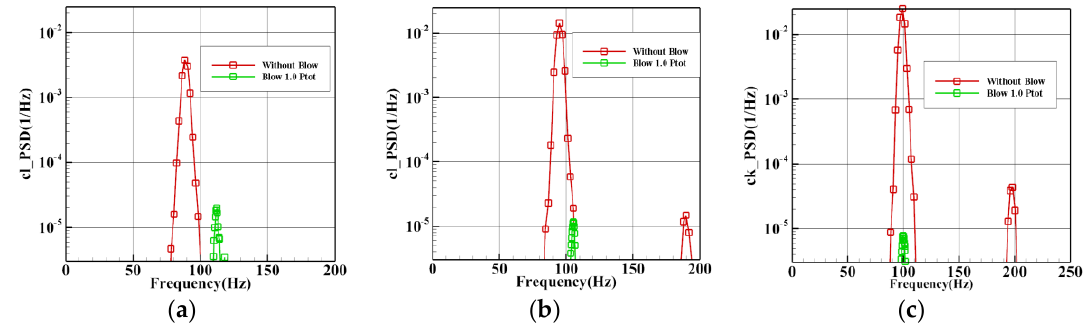
Figure 13. PSDs of unsteady lift coefficient histories under different blowing total pressures at different incidence angles: ( a ) 5.0°, ( b ) 5.5°, and ( c ) 6.0°.